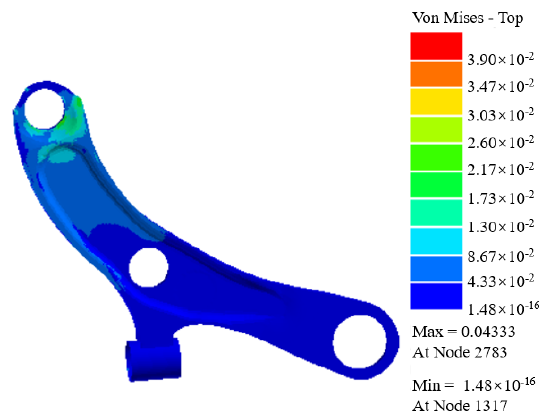
Figure 6. Stress contour of control arm under in X axial unit load of outer point.